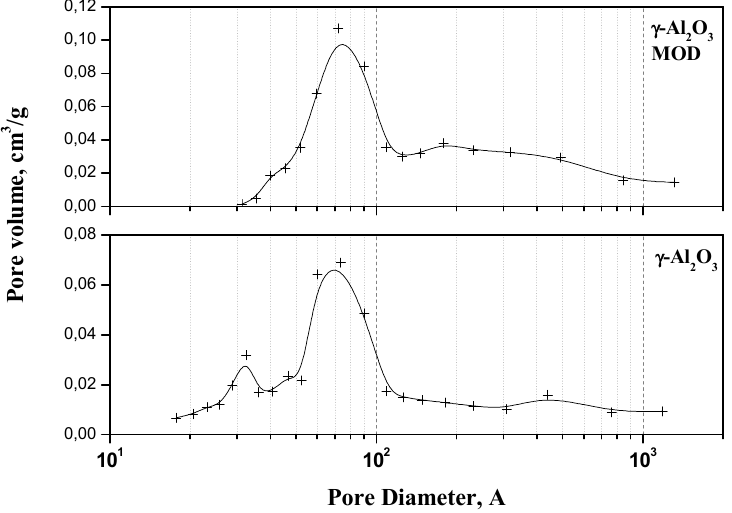
Figure 1. Pore distribution on gamma alumina before and after modification.